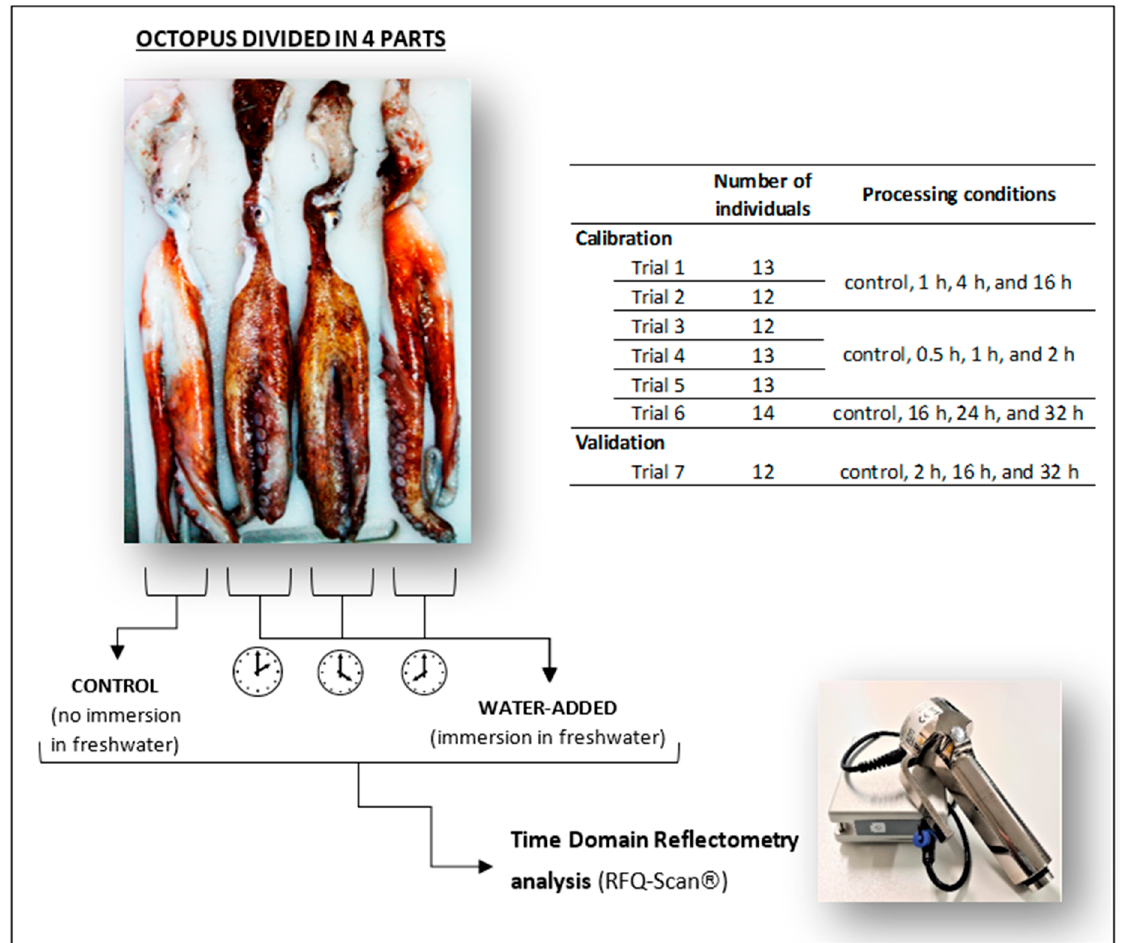
Figure 1. Schematic representation of water addition trials with Octopus vulgaris . Each octopus was divided into 4 parts, with one part used as the control, and the three remaining parts immersed for different periods (between 0.5 and 32 h) in freshwater. Time domain reflectometry analysis was performed with an RFQ-Scan®device. A total of six trials with 12–14 octopus were performed for the calibration of the device, and one trial with 12 octopus was performed for the validation.